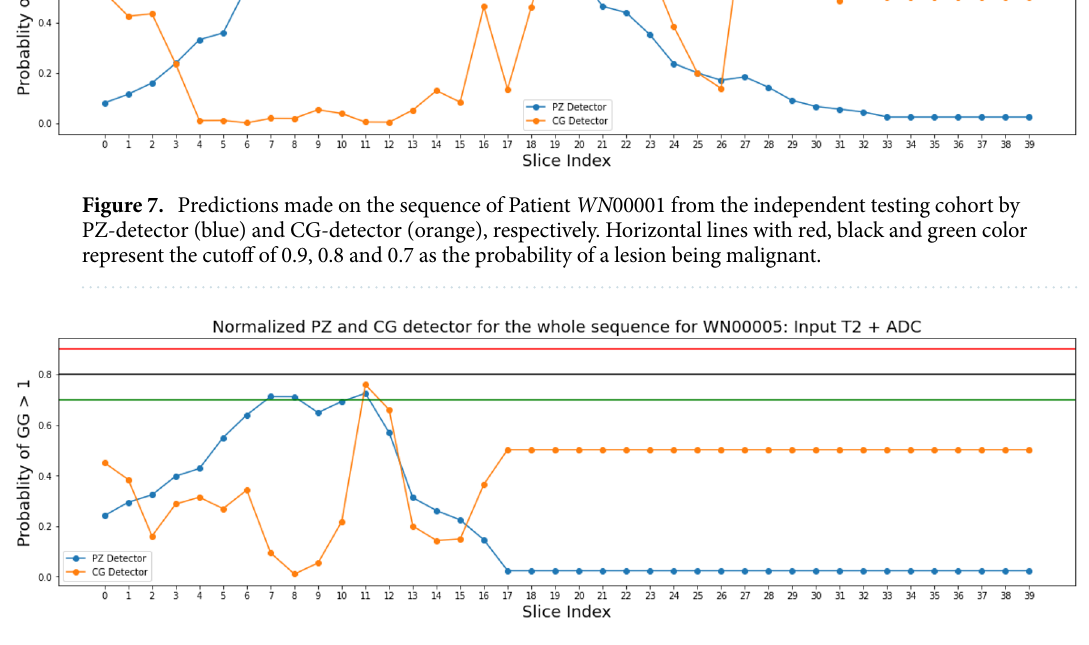
Figure 8. Predictions made on the sequence of Patient WN 00005 from the independent testing cohort by PZ-detector (blue) and CG-detector (orange), respectively. Horizontal lines with red, black and green color represent the cutoff of 0.9, 0.8 and 0.7 as the probability of a lesion being